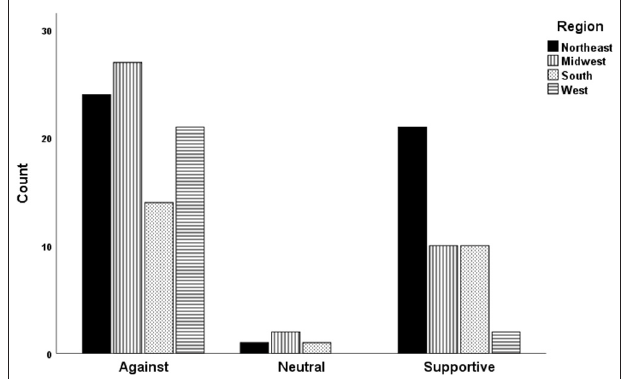
FIGURE 5 | Public opinions categorized based on varying reactions to raw milk consumption in the United States. Neutral or Supportive: The graph represents the number of publications that were indifferent about or advocated the consumption of raw milk. Media from the Northeast had the most promotion of raw milk